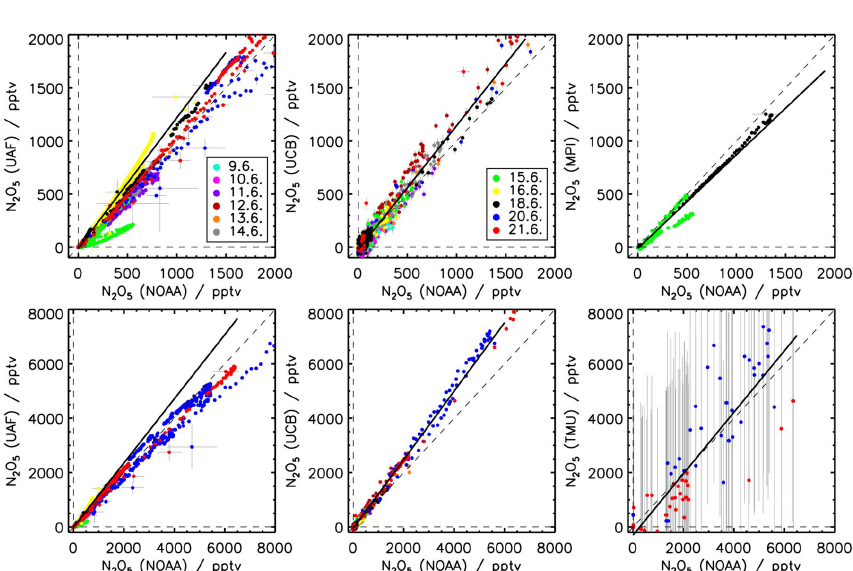
Fig. 3. Correlation between N 2 O 5 data from UAF-CRDS, MPI-LIF and TMU-LIF taking N 2 O 5 by NOAA-CRDS as reference. The range of N 2 O 5 mixing ratios is limited to 2000,pptv in the upper panels, because N 2 O 5 mixing ratios were below this value during most of the experiments. Solid black lines give the results of the regression